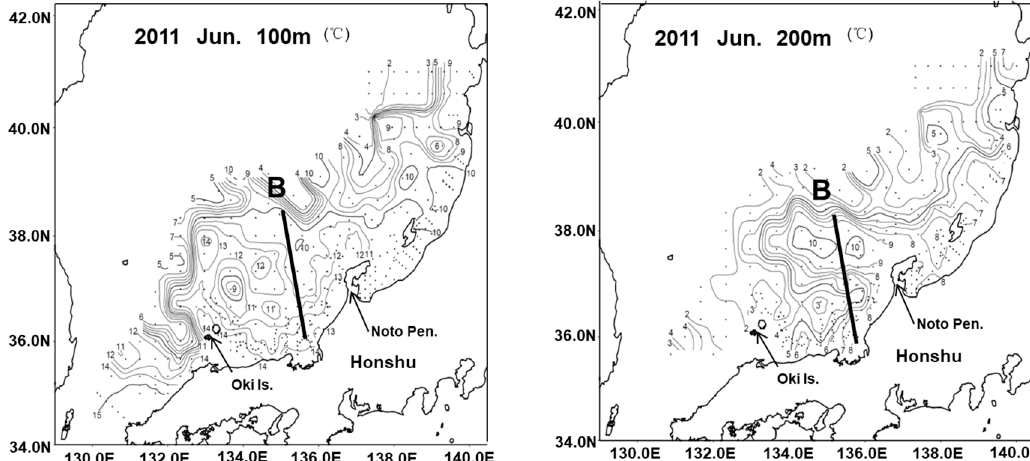
Figure 5. A quick map of the horizontal distributions of temperature at the depths of 100 m and 200 m.